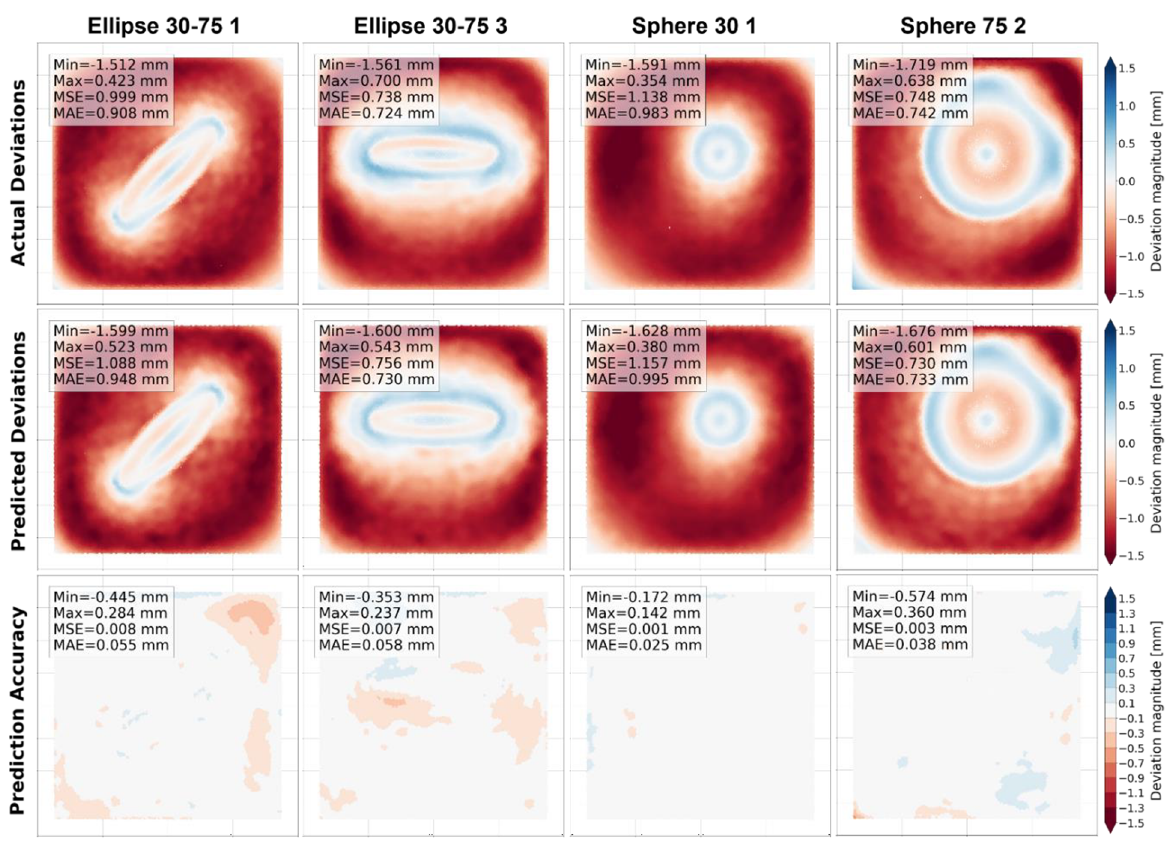
Figure 3. Comparison between measured and predicted deviations and resulting prediction accuracy for four out of eight training geometries (see Table